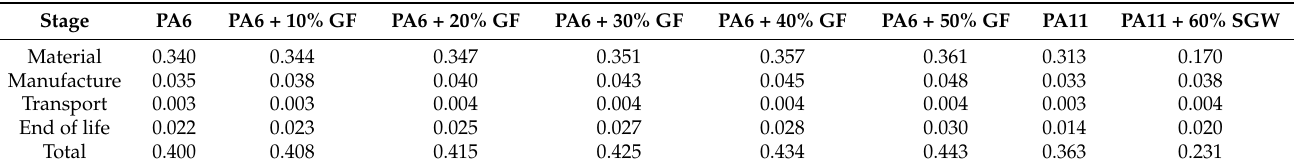
Table 4. Carbon footprint (kg CO 2 ) by composite and life cycle analysis (LCA) stage with a life expectancy of 10 years.